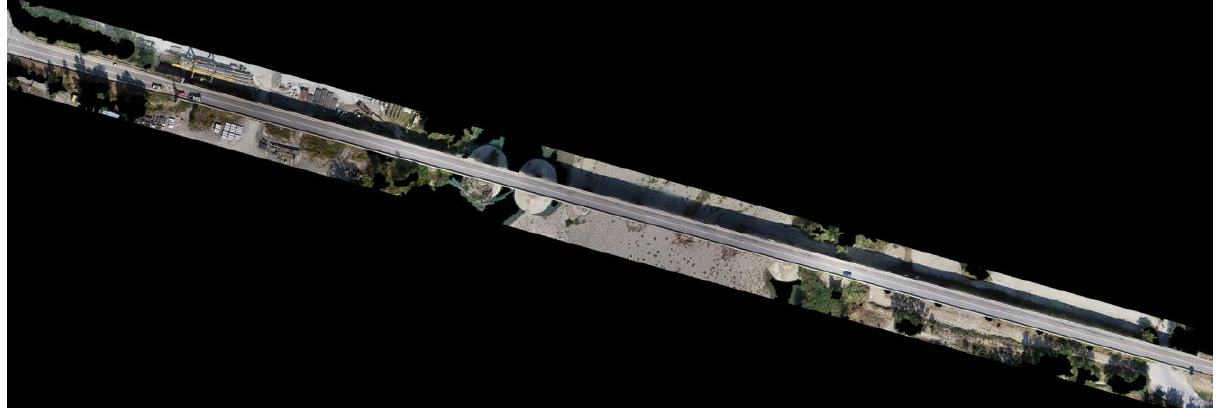
Figure 2. Pont cloud obtained by laser-scanner survey.